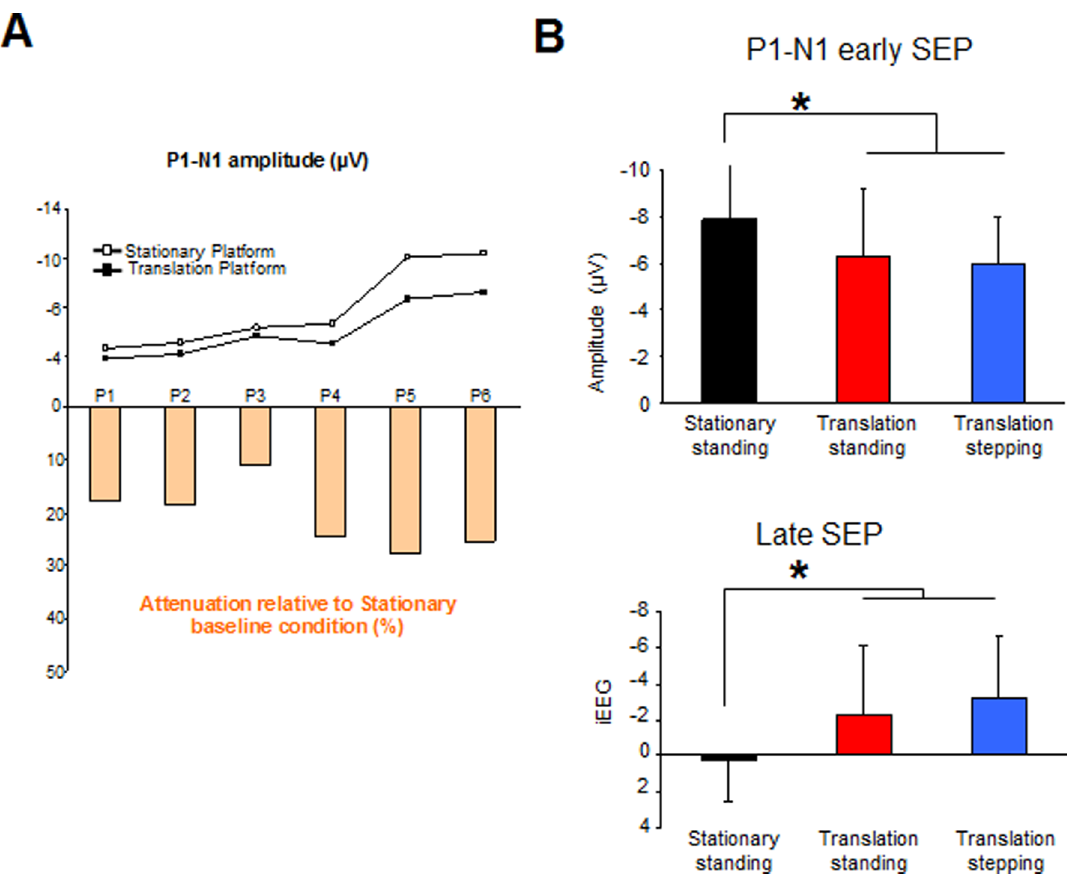
Figure 3. Mean P1-N1 SEP amplitude of each participant (P1–P6) for the Stationary and Translation platform conditions (upper panel). Normalized attenuation for the translation condition relative to the Stationary condition (bottom panel). The mean attenuation for the 6 participants was of 21% ( 6 6). B: Mean amplitudes for 6 participants of the P1-N1 early SEP and mean integral of EEG activity (iEEG, late SEP) computed in a time window comprising between early SEP ending until 600 ms (*: p , 0.05). Right view) together with the somatosensory source (Fig. 4, top view). This lateralized activation observed over the right hemi- sphere might be due to lateralized stimulation (i.e., left translation of the platform).